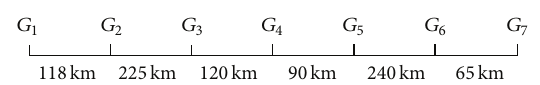
Figure 4: Stops and mileage chart of railway passenger transport corridor.